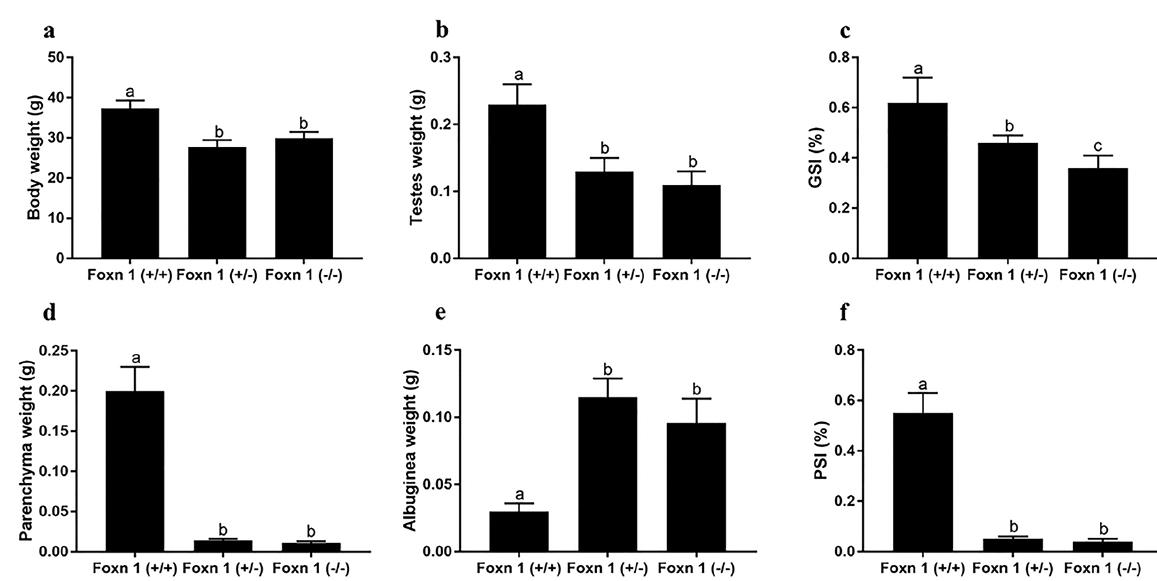
Figure 2. Body and testicular biometry. Different letters (a,b,c) are significantly different ( P<0.05